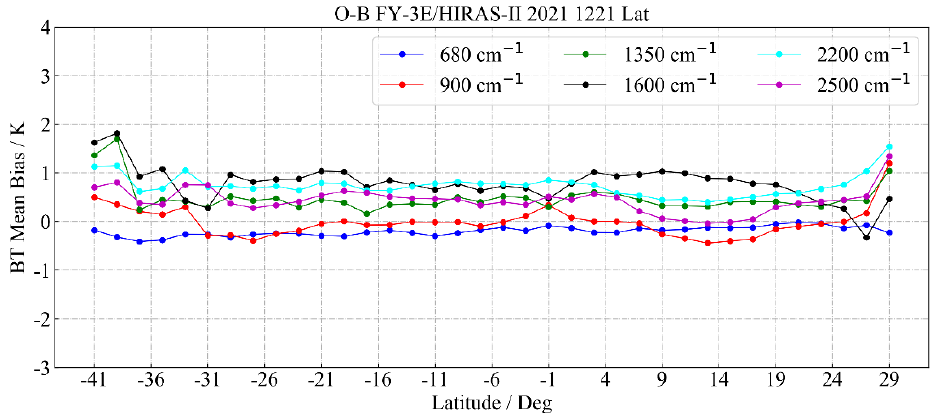
Figure 24. Schematic diagram of the variation in the bias of OMB with latitude.